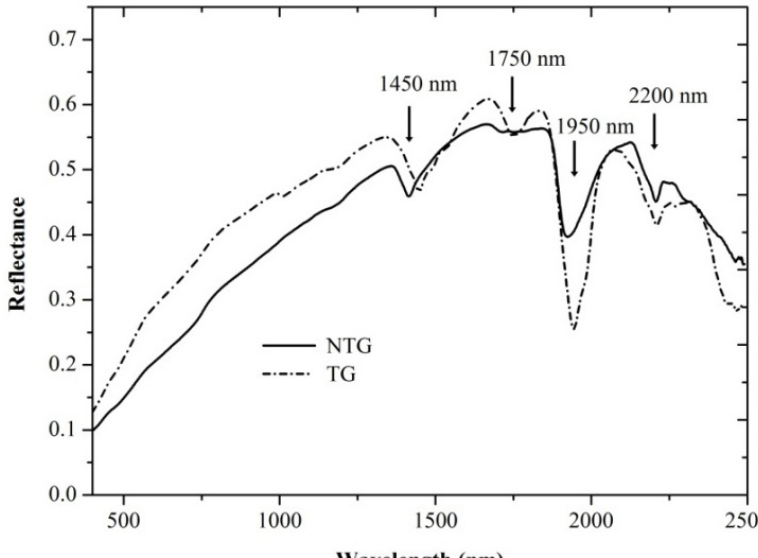
Figure 10. Alluvial soil spectra of EC1 samples treated (TG) and non-treated (NTG) with